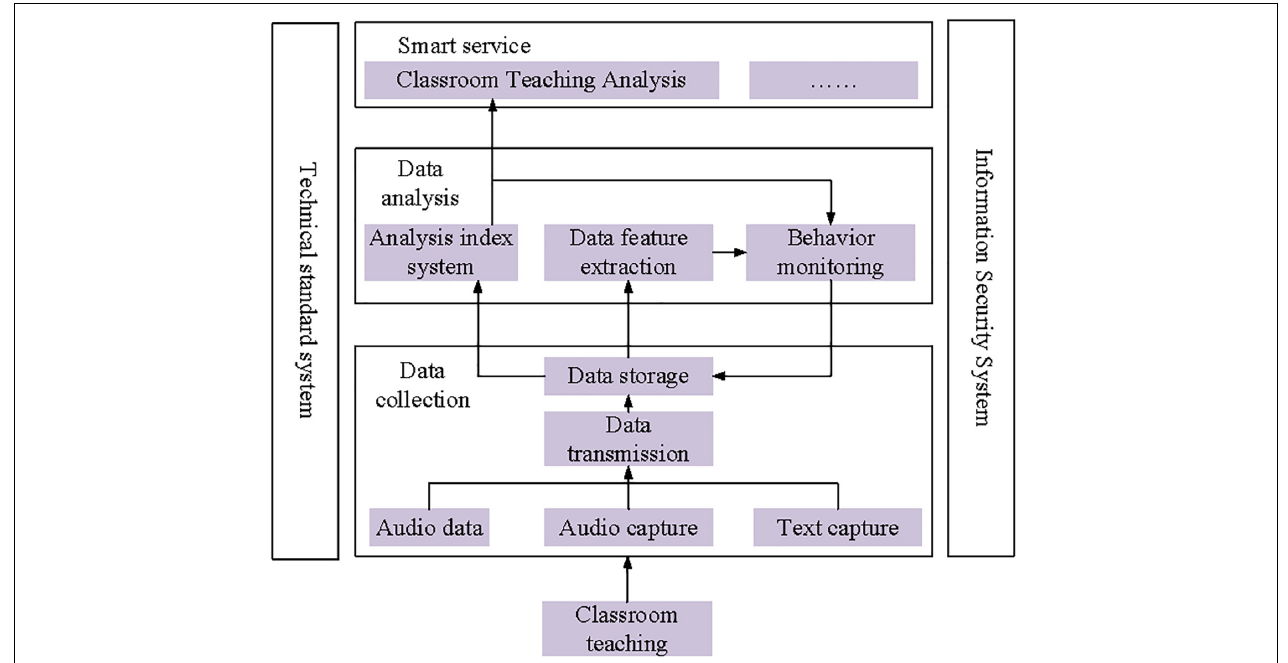
FIGURE 1 | Logic framework of the